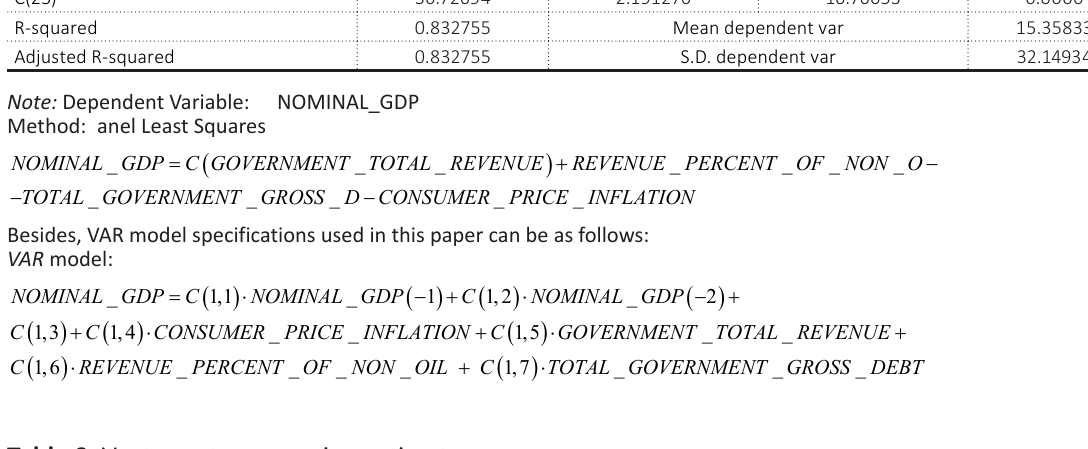
Table 9. Vector auto-regression